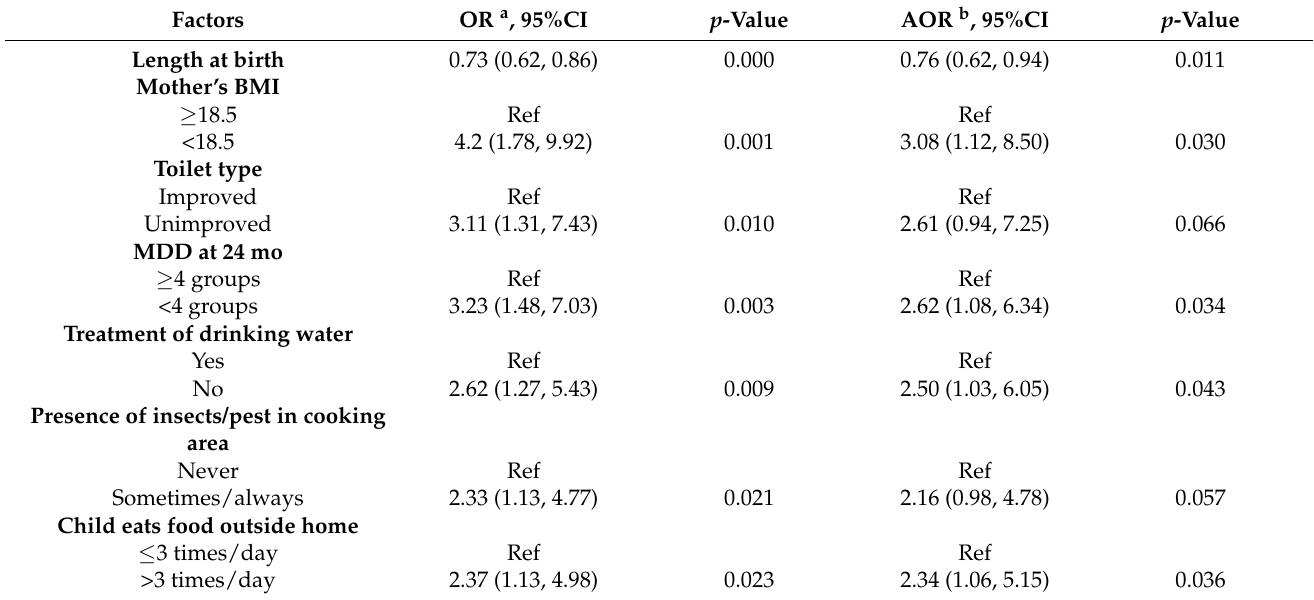
Table 4. Association between food safety behaviour and stunting among school-age children (n =